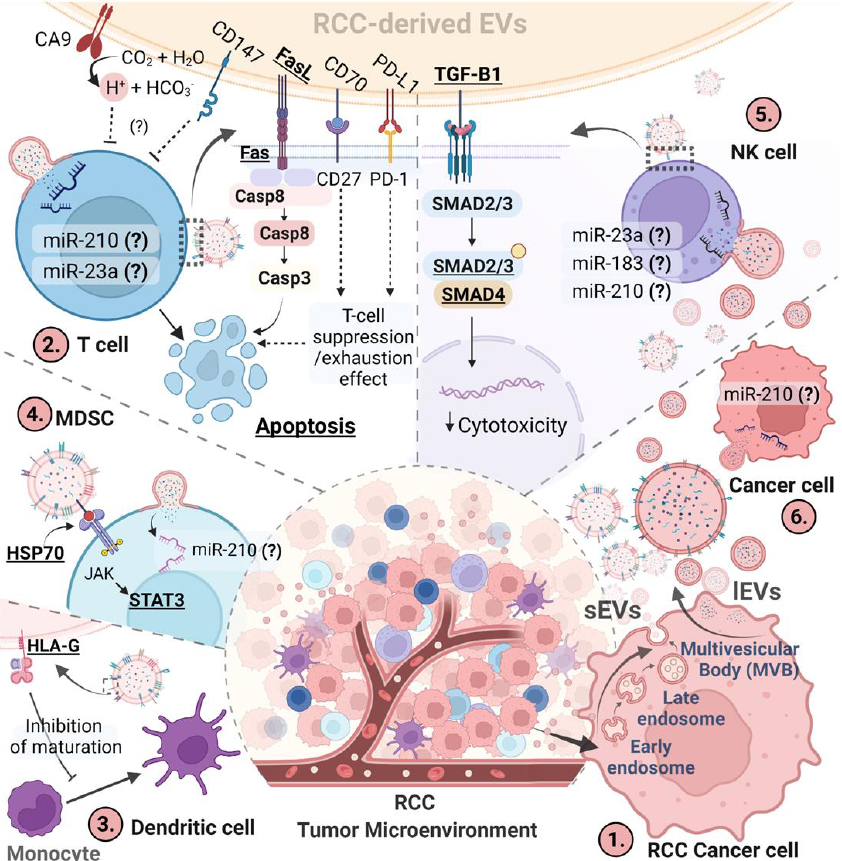
Figure 1. The role of EVs in immune escape of RCC; (?)—potential immunosuppressive mechanism not confirmed in the context of RCC-derived EVs but described in other cancer types. RCC cancer cells secrete small EVs (sEV) through the endocytic pathway or large EVs (lEVs) by membrane blebbing ( 1 .). EVs inhibit T-cell proliferation and induce apoptosis by delivering FasL, cause T-cell exhaustion and apoptosis through CD70, and inhibit T-cell function by creating an acidic microenvironment through the enzyme CA9 and through the delivery of CD147 or PD-L1. EV-associated miR-23a represses through the transcription factor BLIMP-1, CD8+ T lymphocyte cytotoxicity, and effector cell differentiation ( 2 .). EVs block monocyte differentiation and maturation by delivery of HLA-G. ( 3 .). EVs induce the suppressive activity of MDSCs by Hsp70-related p-Stat3 activation EV-delivered miR-210 up- regulates MDSC suppressor function by increasing arginase activity and NO production ( 4 .). EVs cause dysfunction of NK cells by delivery of TGF-B1, which induces the TGF- β /SMAD pathway. EV-associated miR-23a suppresses NK function by blocking the expression of CD107a and EV-delivered miR-183 binds and represses DAP12, an important signal adaptor required for proper NK cytotoxic activity ( 5 .). Hypoxia induces overexpression of miR-210 in RCC cancer cells, which downregulates PTPN1, HOXA1, and TP53I11 genes and decreases susceptibility to cytotoxic T-cell lysis ( 6 .). Created with BioRender. Abbreviations: BLIMP-1-B lymphocyte-induced maturation protein-1; CA-9—Cancer antigen 9; Casp—caspase; CD—Cluster of differentiation; CO 2 —carbon dioxide; EVs—extracellular vesicles; FAS—Fas Cell Surface Death Receptor; FasL—Fas Cell Surface Death Receptor Ligand; H+—hydrogen ion; HCO 3 —bicarbonate anion; HLA—human leukocyte antigen; H 2 O—water; HSP—heat shock protein; JAK—Janus-activated kinases; lEVs—large extracel- lular vesicles; MDSC—Myeloid-derived suppressor cell; miR—microRNA; MVB—Multivesicular body; NK—natural killers; PD-1—Programmed cell death protein 1; PD-L1—Programmed cell death protein ligand 1; RCC—renal cell carcinoma; sEVs—small extracellular vesicles; SMAD—Suppressor of Mothers against Decapentaplegic; STAT—Signal transducers and activators of transcription; TGF- β —Transforming Growth Factor- β